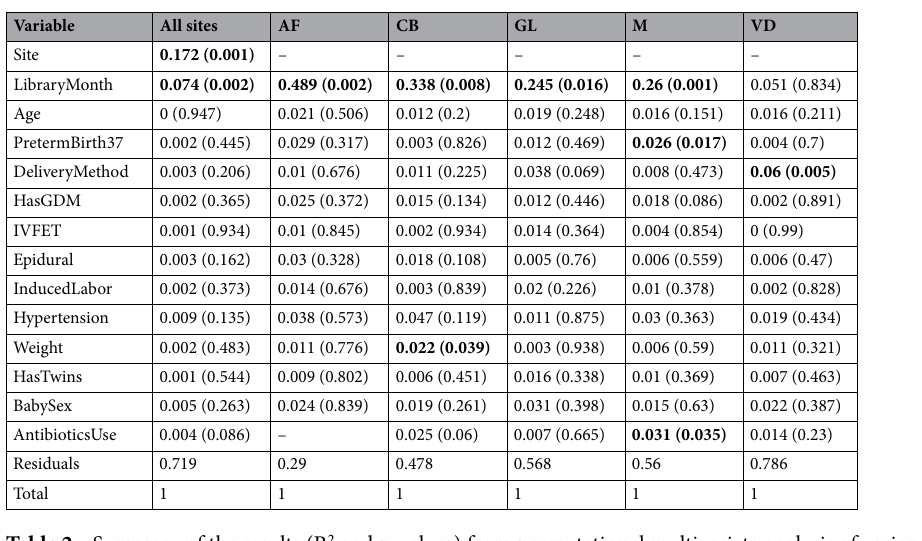
Table 2. Summary of the results (R 2 and p-values) from permutational multivariate analysis of variance (PERMANOVA). AF, amniotic fluid; CB, umbilical cord blood; GL, gastric liquid; M, meconium; VD, cervicovaginal discharge. Significant values are in